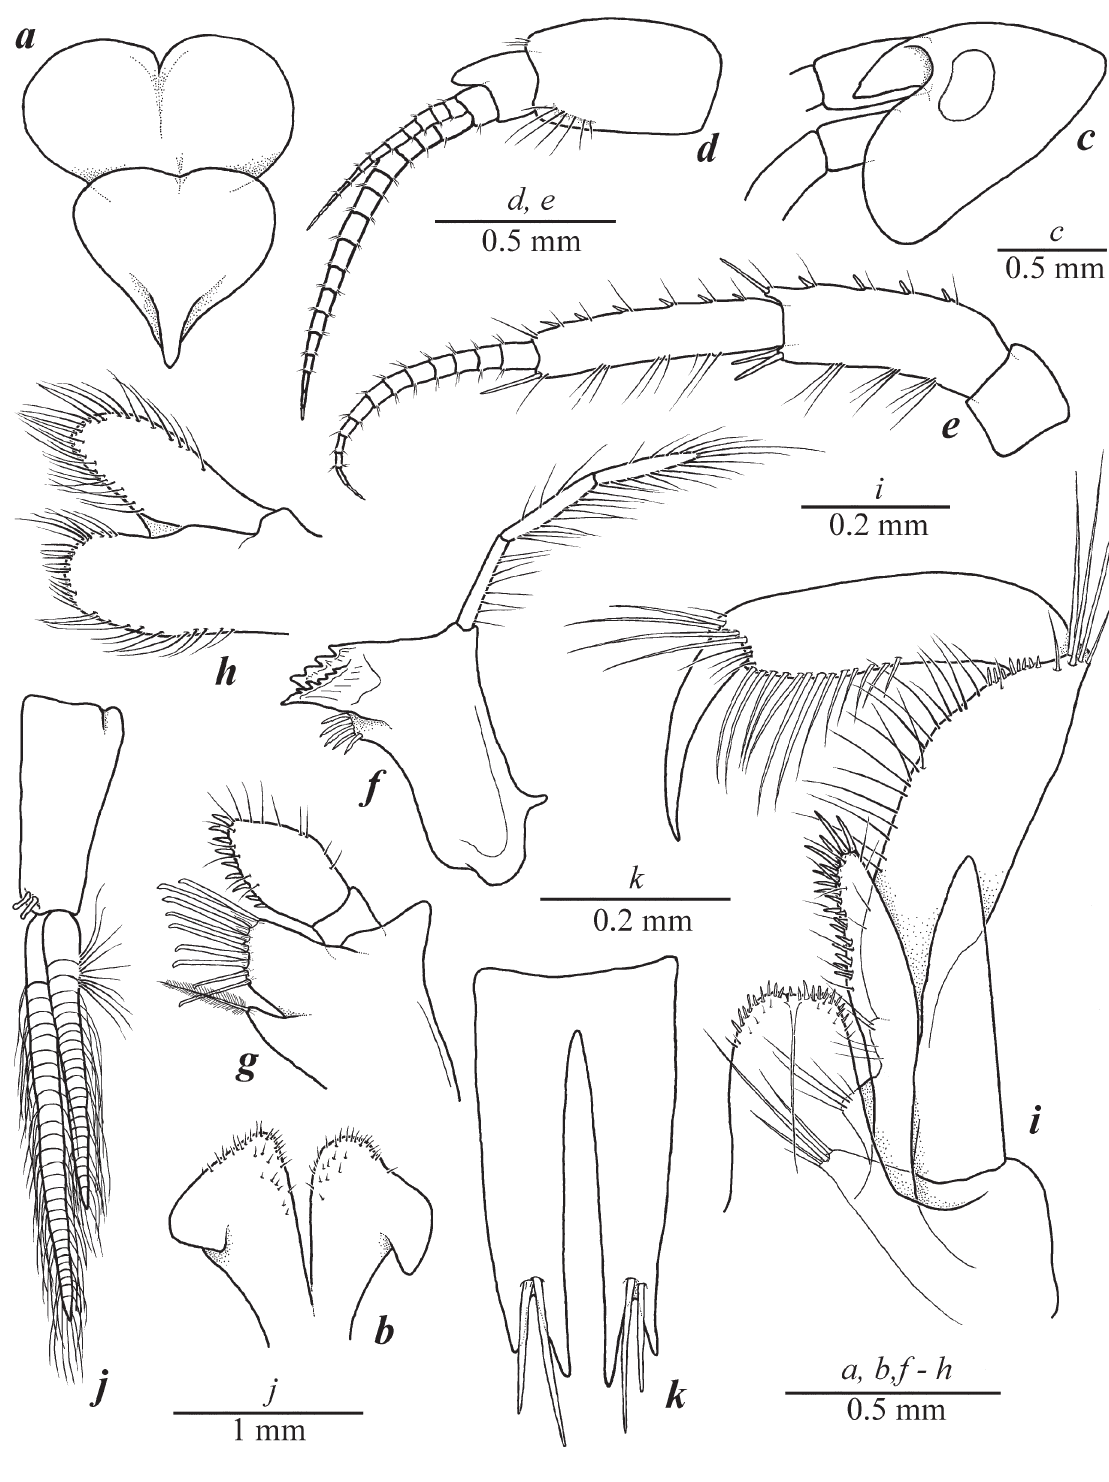
Fig. 2. Liljeborgia associata sp. nov., female (LEMMI) from Vostok Bay of the Sea of Japan. a . Upper lip. b . Lower lip. c . Head. d . Antenna 1. e . Antenna 2. f . Mandible. g . Maxilla 1. h . Maxilla 2. i .